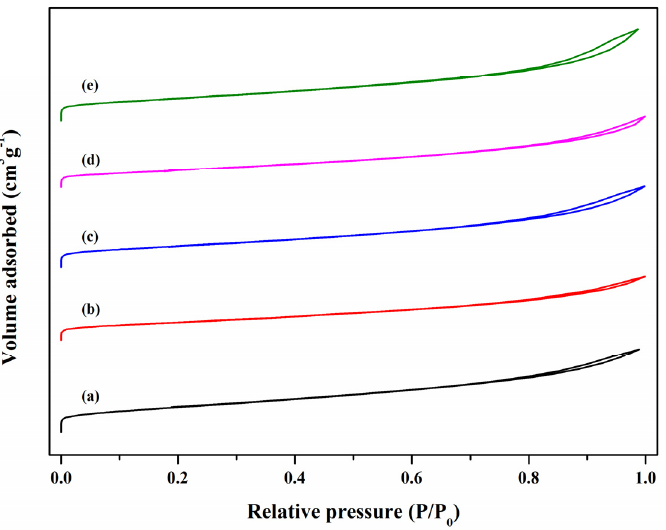
Figure 3. N 2 adsorption-desorption isotherms of ( a ) OMS-2, ( b ) 1Ni/OMS-2, ( c ) 3Ni/OMS-2, ( d ) 5Ni/OMS-2, and ( e ) 10Ni/OMS-2.